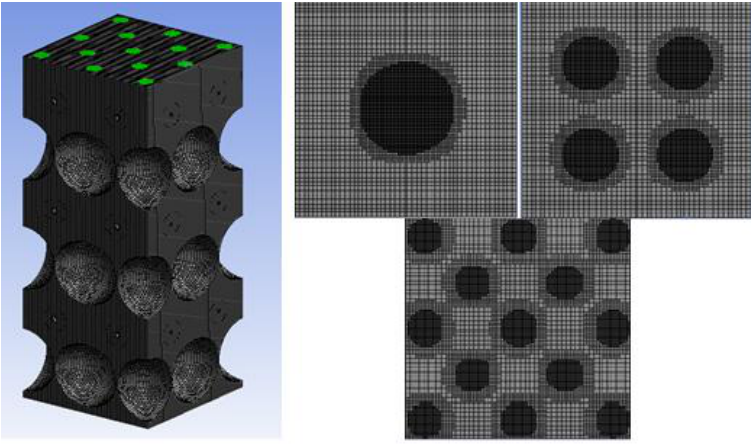
Figure 10. CFD model with different numbers of liquid inlet.